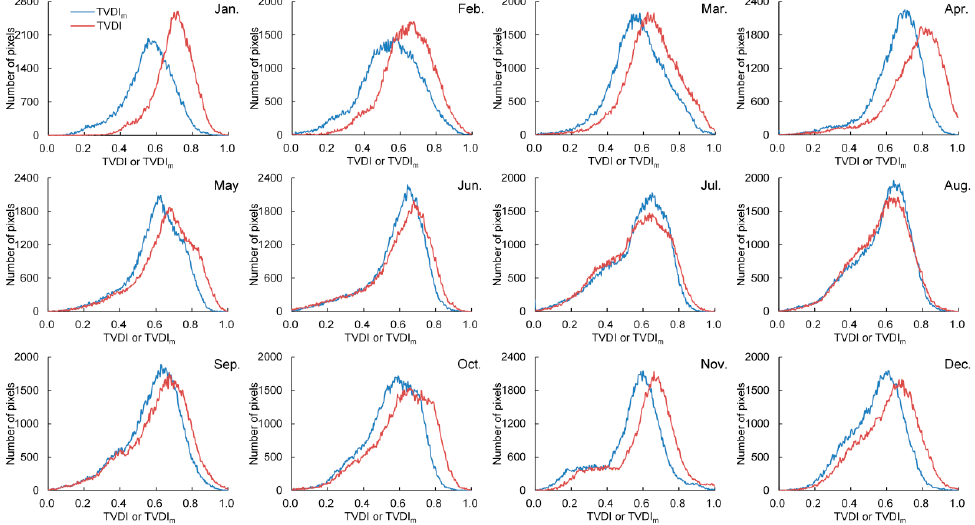
Figure 14. Comparison of TVDI and TVDI m histograms in 2005.